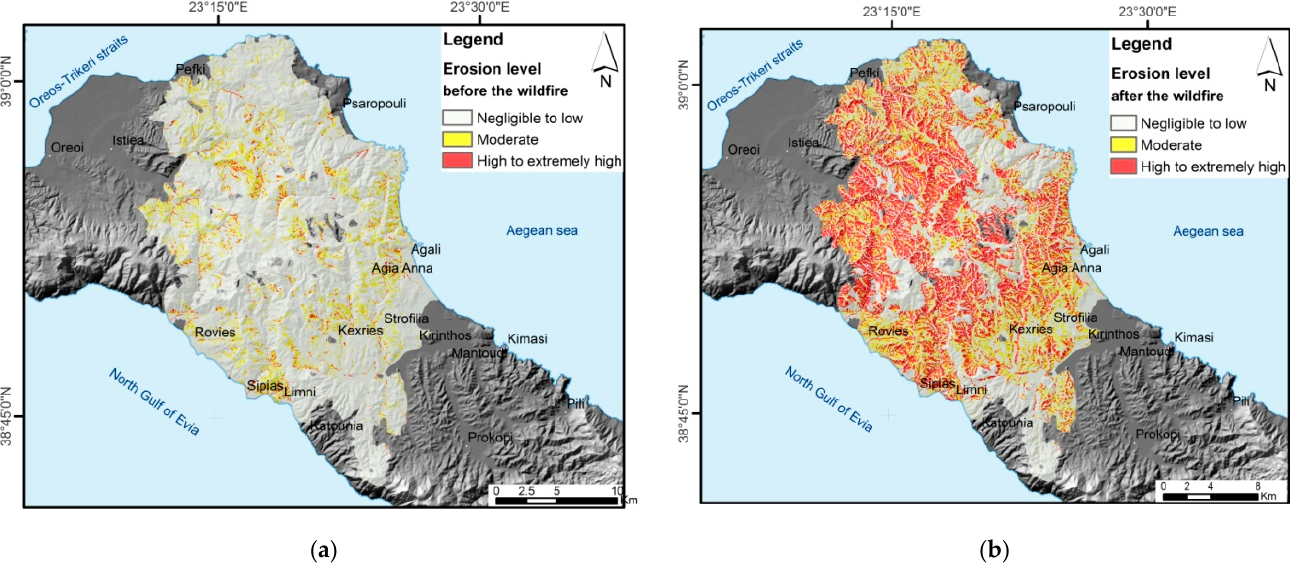
Figure 8. Erosion level for the fire-affected sub-area ( a ) before the wildfire and ( b ) after the wildfire.